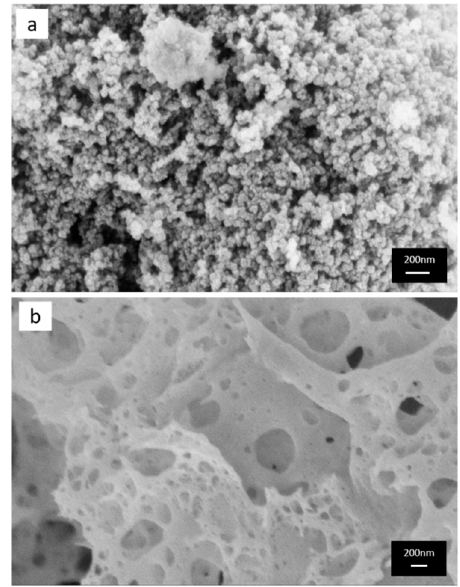
Figure 2. FE-SEM images of ( a ) the co-precipitation method and ( b ) the solution combustion synthesis